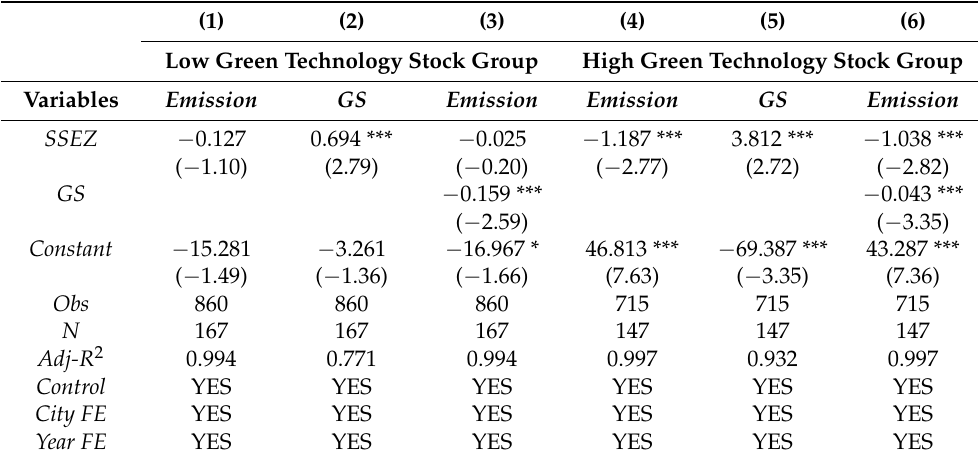
Table 8. Heterogeneity analysis by green technology stock